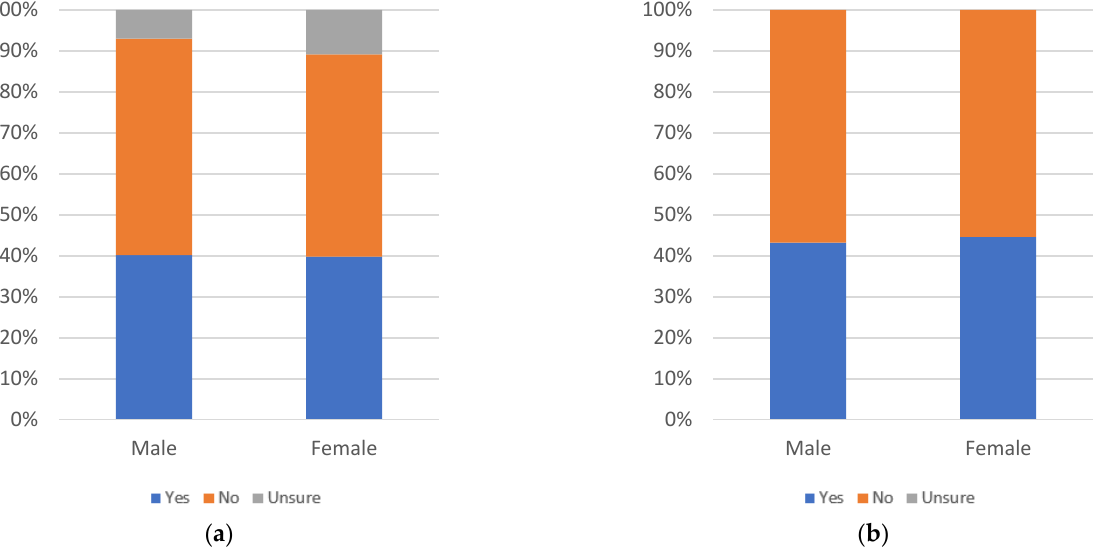
Figure 58. Label annoyingness, by gender: ( a ) with uncertain respondents (left) and ( b ) without uncertain respondents (right).